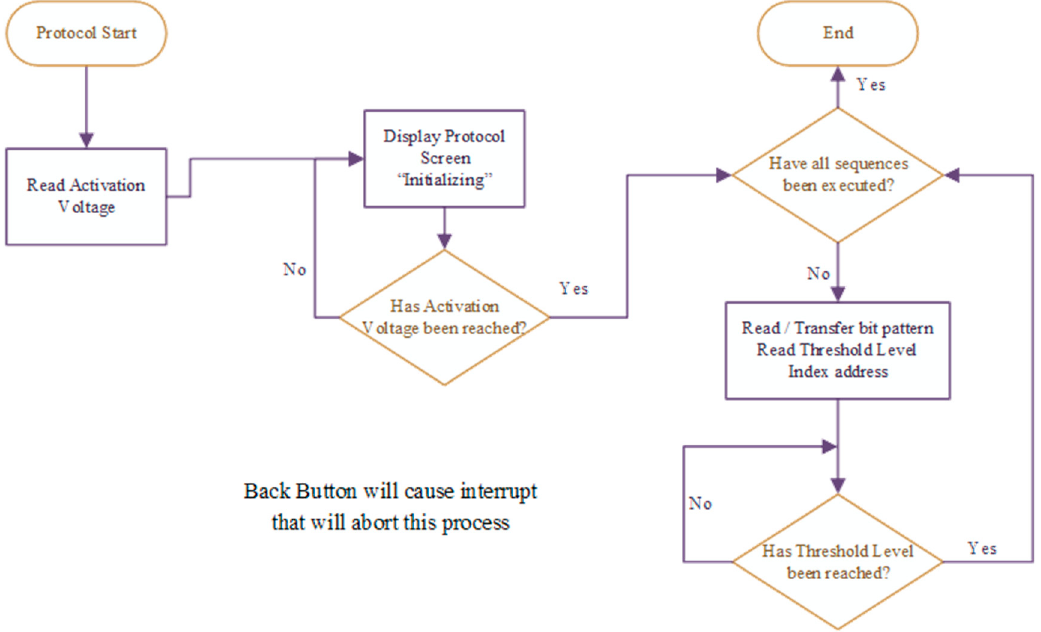
Figure 9. Protocol control flow.